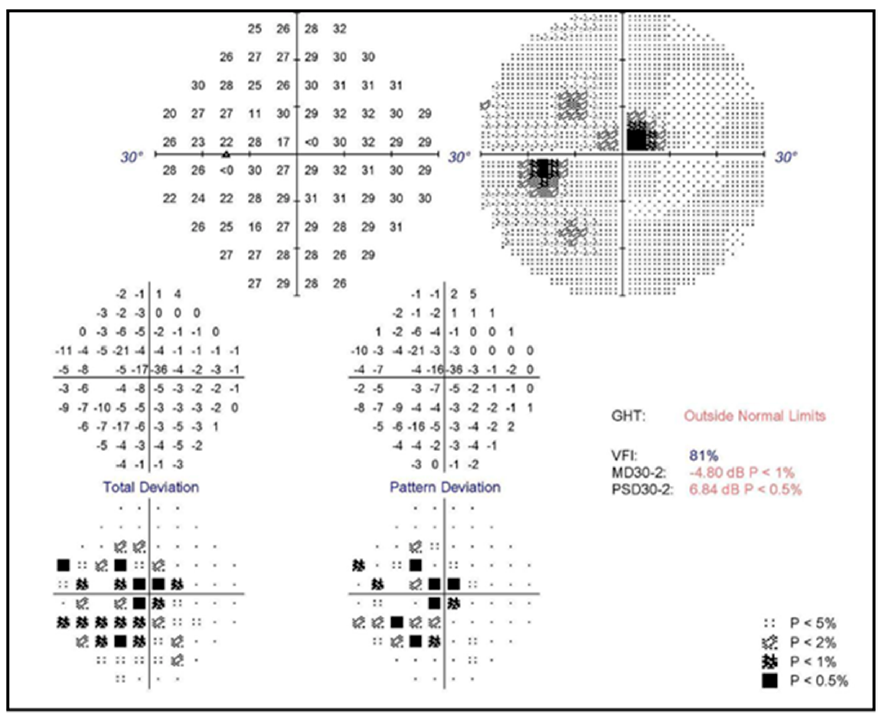
Figure 3. Auto-perimetry (Humphrey 30 − 2) of the left eye. A paracentral scotoma with mean devi- ation of − 4.80 dB was noted on the left eye. Table 1. Clinical laboratory results of the patient. Except for HbA1c*, other data were negative or within normal limits.